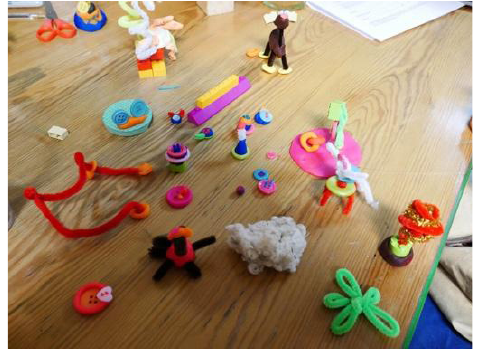
Figure 5. The village community (source: created by